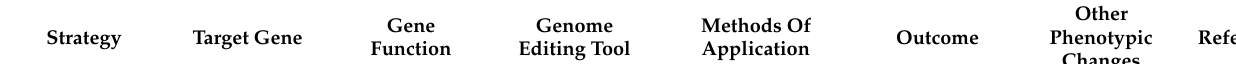
Table 4. Targeted genome editing tools for disease resistance in rice against plant